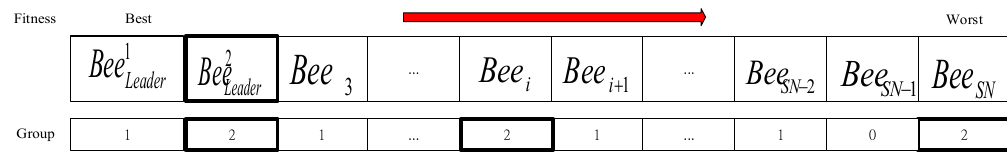
Figure 11. Group the ungrouped bees.